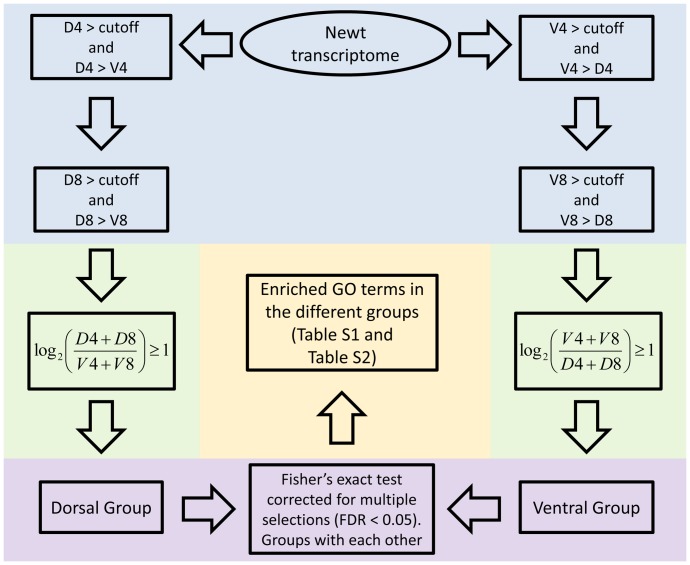
Workflow used to select transcripts for comparison of expression between the dorsal and ventral iris.Only transcripts expressed above the cutoff (see methods, light blue) and up-regulated at least 2-fold (light green) were included. Fisher’s exact test corrected with multiple selections (FDR <0.05) was used to compare the GO of the two groups (light purple). Enriched GO terms were found (light yellow).